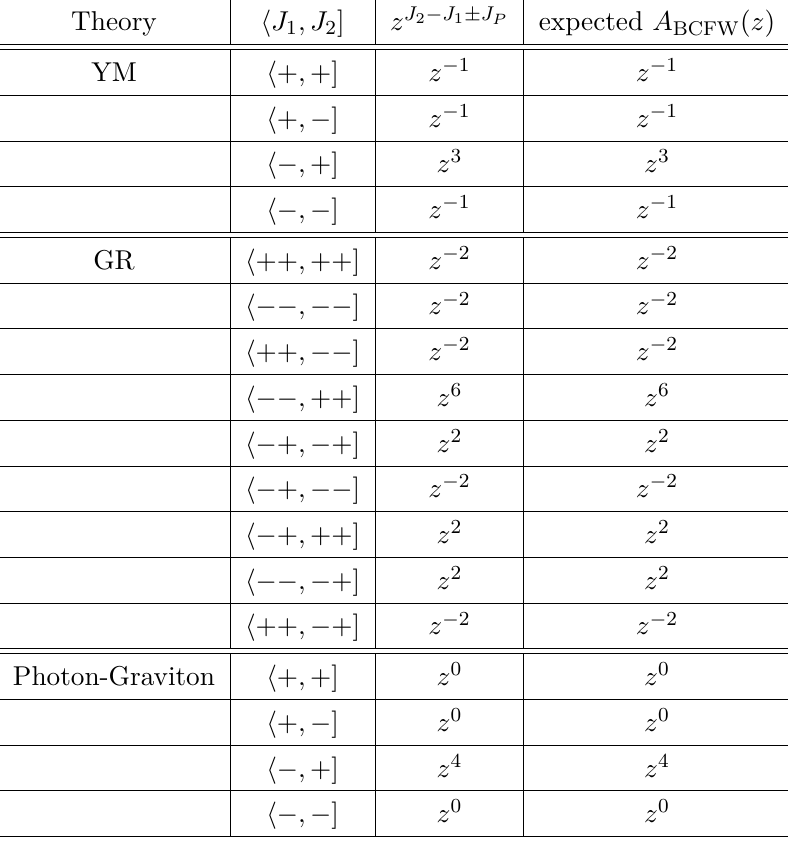
Table 1 . Summary of the large- z behavior for various helicity configurations associated with BCFW shift h J ] as compared to the results in [24]. Note that the 2D spin J is identified with the 1 , J 2 4D